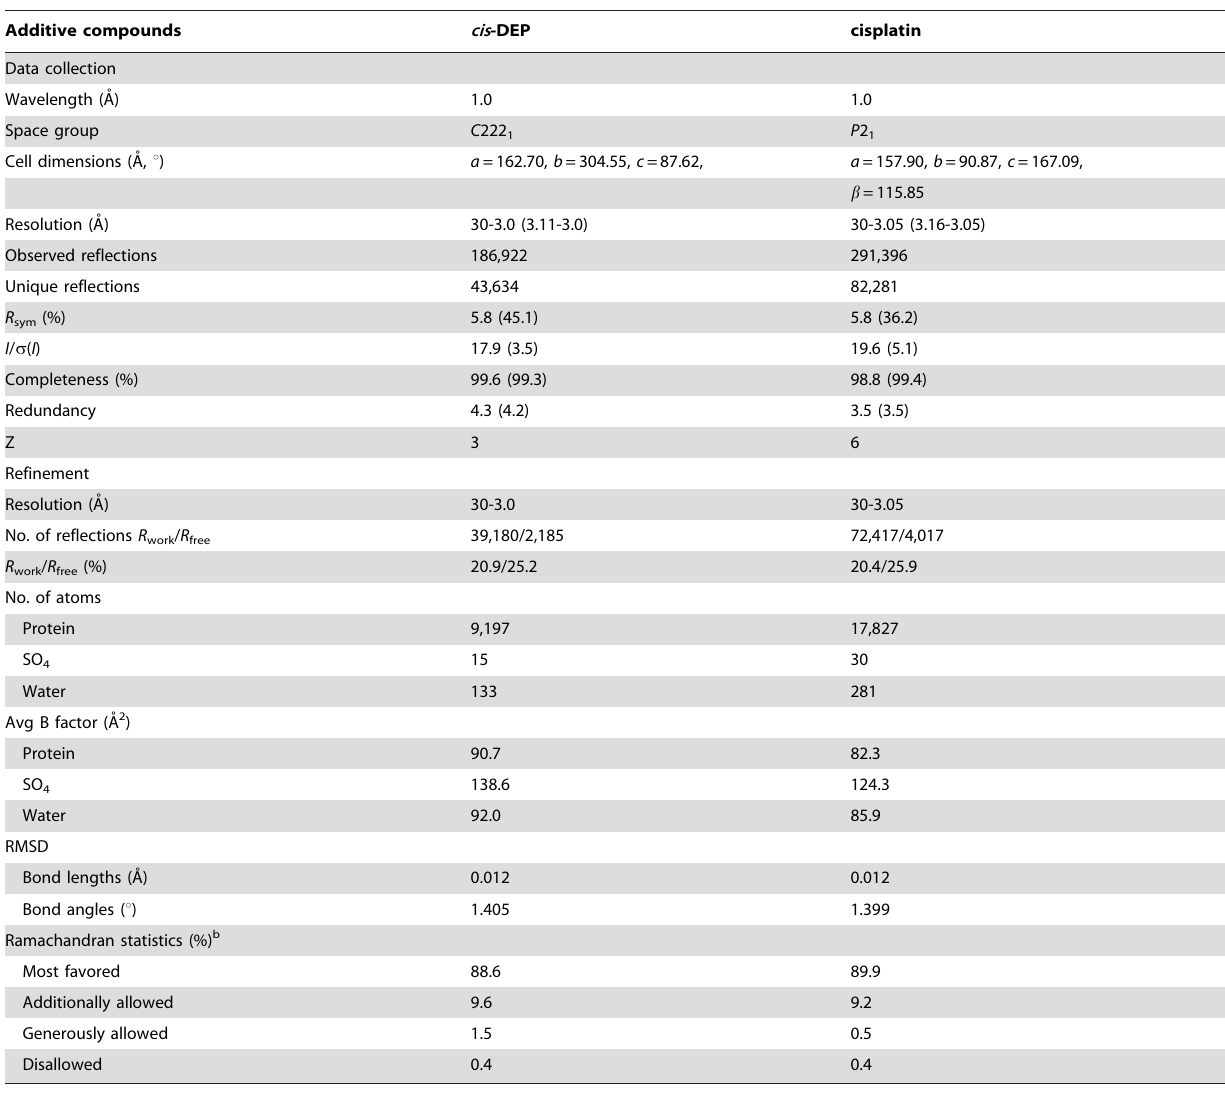
Table 1. Data collection and refinement statistics a